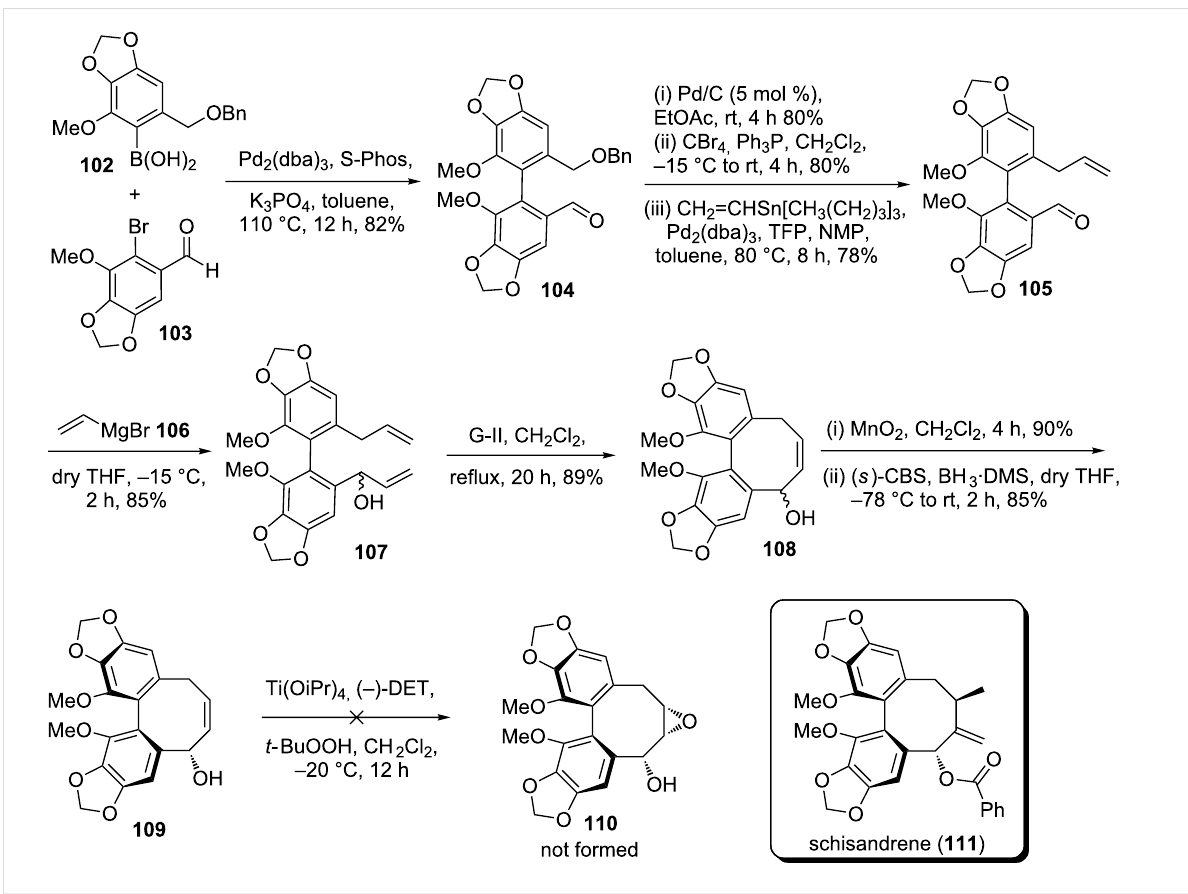
Scheme 16: Synthesis of the dibenzocyclooctadiene core of